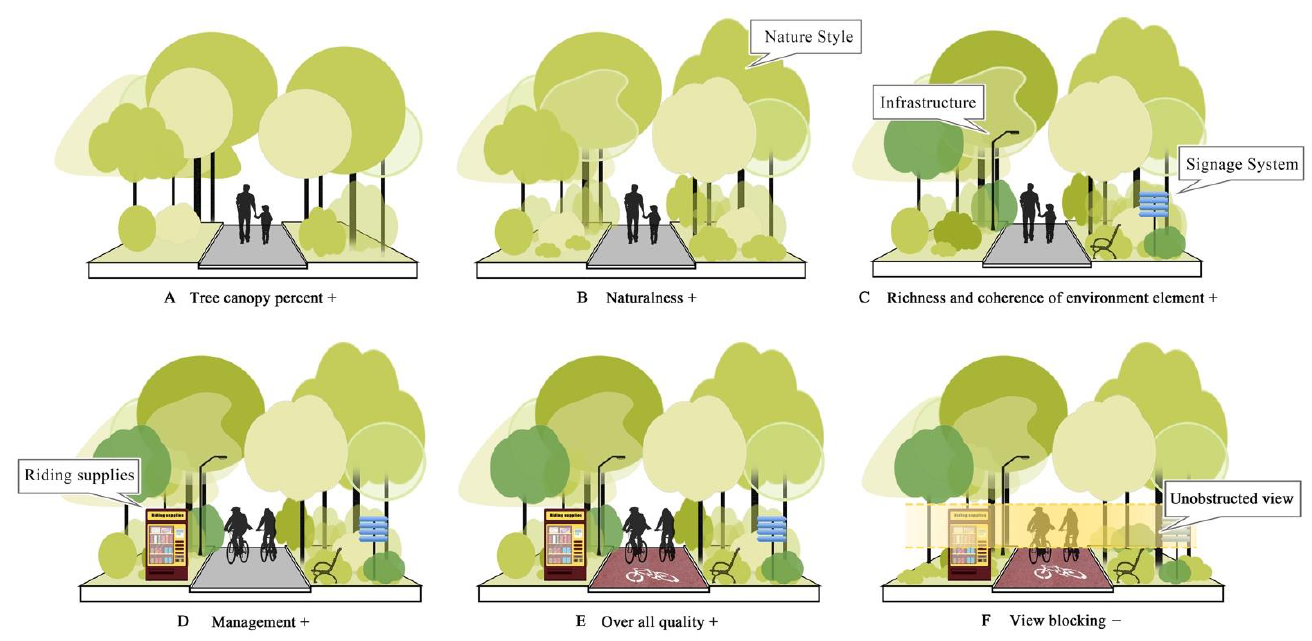
Figure 8. Idealized spatial layout model for greenway. ( A ) Add tree canopy; ( B ) Nature style; ( C ) Richness of plants and increase infrastructure; ( D ) Well managed; ( E ) High quality space; and ( F ) View open.